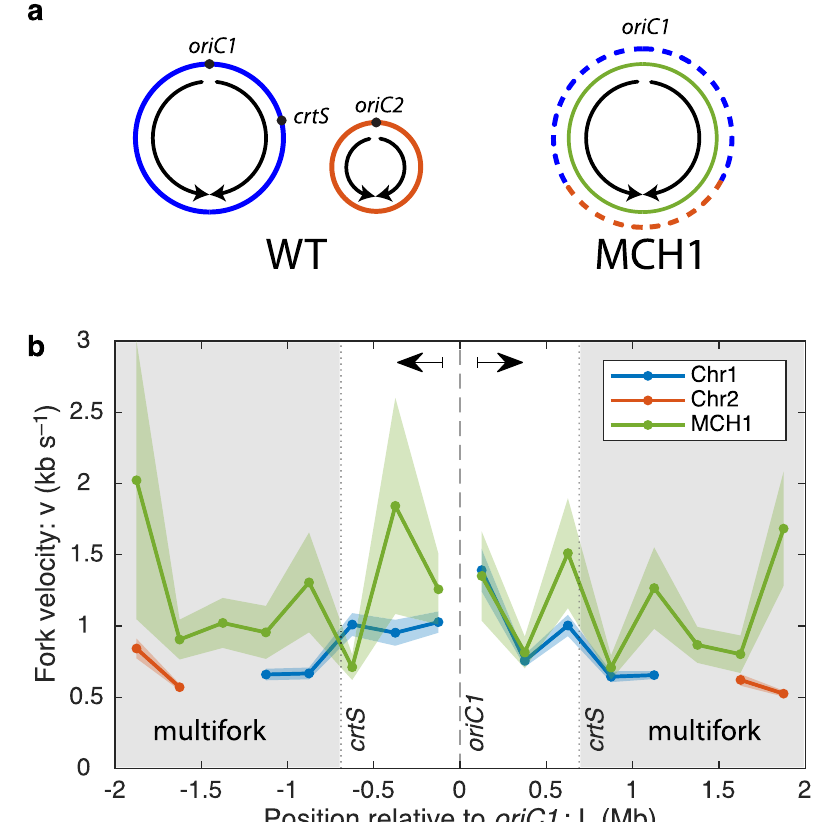
Fig.4|Reducingforknumberincreasesforkvelocity.a Themonochromosomal strain MCH1 has a single chromosome (green) which was constructed by recom- bining Chr2 (orange) into the terminus of Chr1 (blue) 55 . Under slow growth con- ditionsthe fi rstpartofthechromosomeinbothstrainsisreplicatedbyasinglepair offorks.Whentheforkreachesthe crtS sequenceontherightarm,Chr2isinitiated at oriC2 in the wild-type cells. All of Chr2 and the residuum of Chr1 replicate